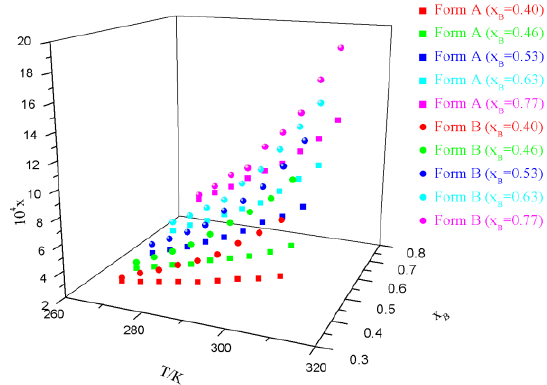
Figure 3. Experimental solubility ( x A ) of form A and form B in ethyl acetate + toluene binary solvents.